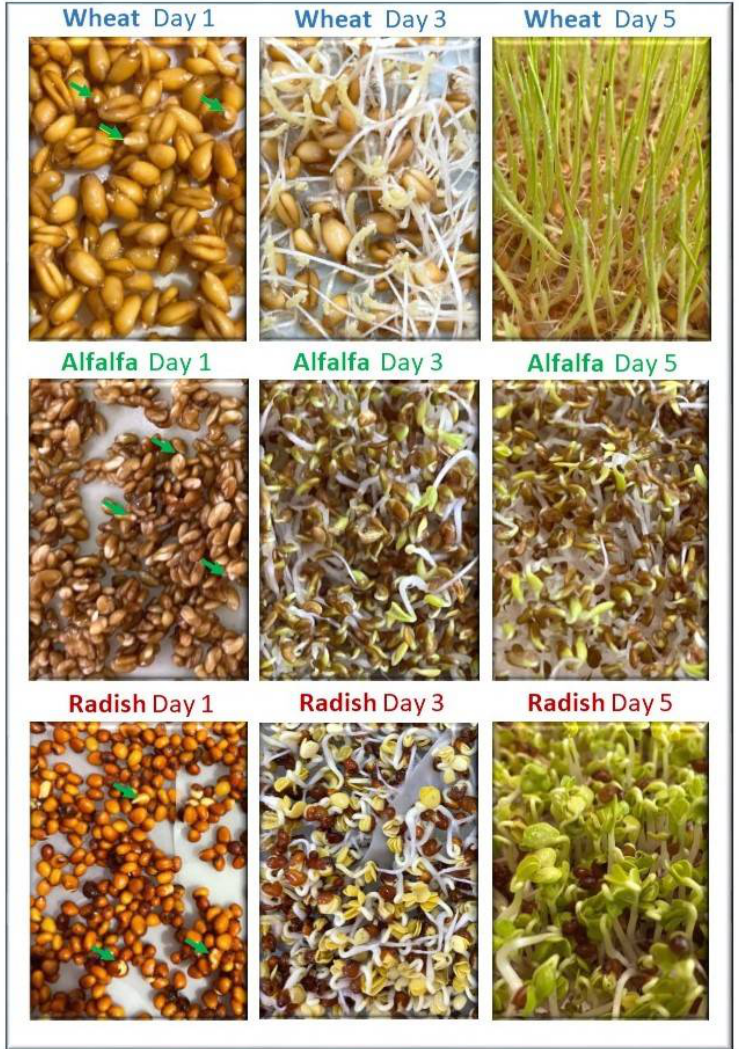
Figure 1. Germination of wheat, alfalfa, and radish sprouts. Green arrows on day 1 indicate the beginning of germination. Table 1. Crude fat and proteins evolution during 7 days of germination for the wheat, alfalfa,